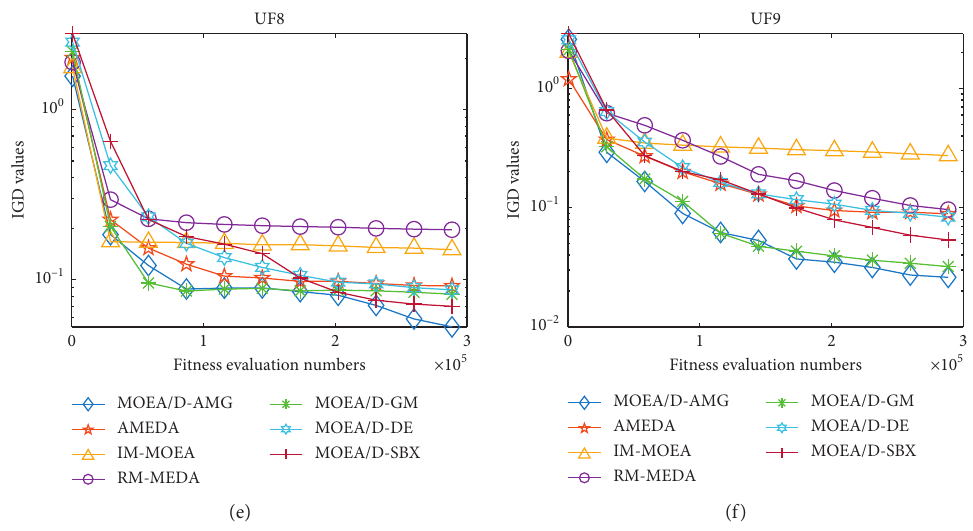
Figure 3: The convergence curves of all the compared algorithms on UF1-UF2 and UF6-UF9.